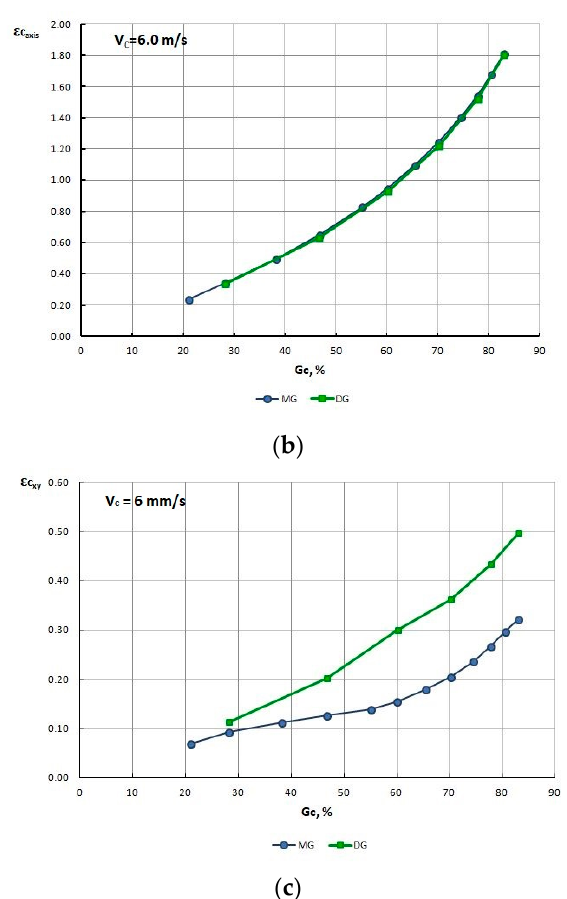
Figure 14. Change of strain level on the surface ( a ), axis ( b ) and non-dilatational strain ( c ) in wires drawn with low MG and high DG single section reductions, at a drawing speed of V c = 6.0 m / s, as a function of the total drawing reduction G c %.